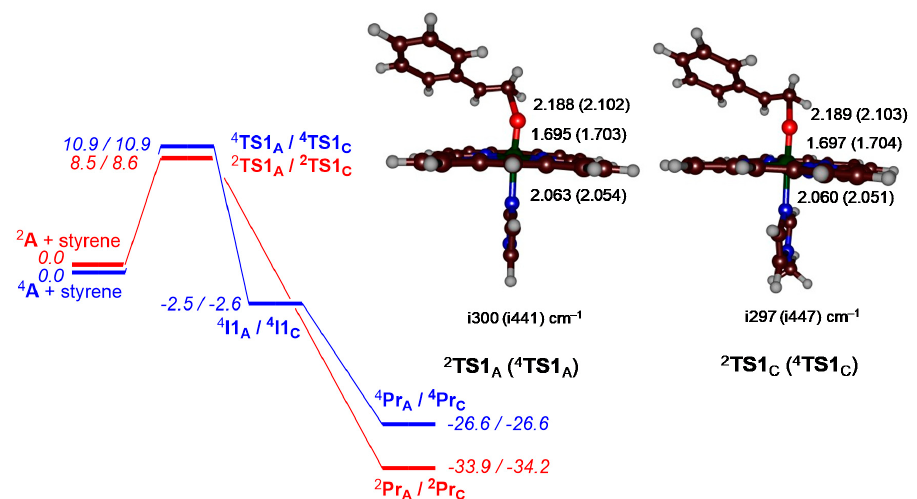
Figure 3. Potential energy landscape of styrene epoxidation by 2,4 A and 2,4 C as calculated at Figure3. Potentialenergylandscapeofstyreneepoxidationby 2,4 A and 2,4 C ascalculatedatUB3LYP / BS1 UB3LYP/BS1 in Gaussian-09. Energies (UB3LYP/BS1//UB3LYP/BS2+ZPE+E solv ) are in kcal mol − 1 with in Gaussian-09. Energies (UB3LYP / BS1 // UB3LYP / BS2 + ZPE + E solv ) are in kcal mol − 1 with respect to spin results in blue. Optimized geometries of the rate-determining transition states give bond lengths in angstroms and the imaginary frequency in cm − 1